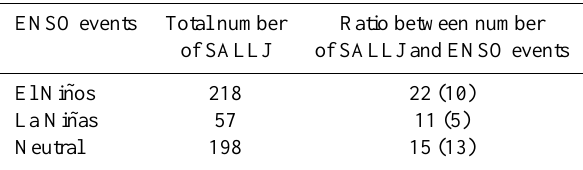
Table 2. Total number of observed SALLJ cases in Santa Cruz for EN, LN and neutral groups and the ratio between the SALLJ and the number of ENSO events during austral summer. The number of ENSO events is shown in the square bracket in the last